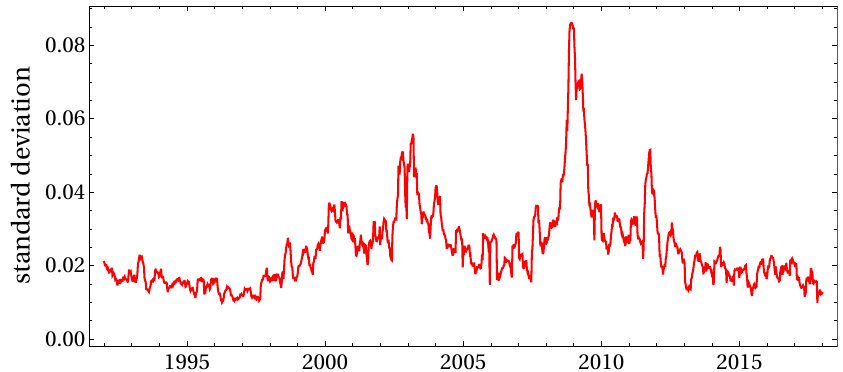
Figure 1. Standard deviation time series for Goodyear from 1992–2018. The return interval is ∆ t = 1 trading day, and the time window has a length of T = 60 trading days.